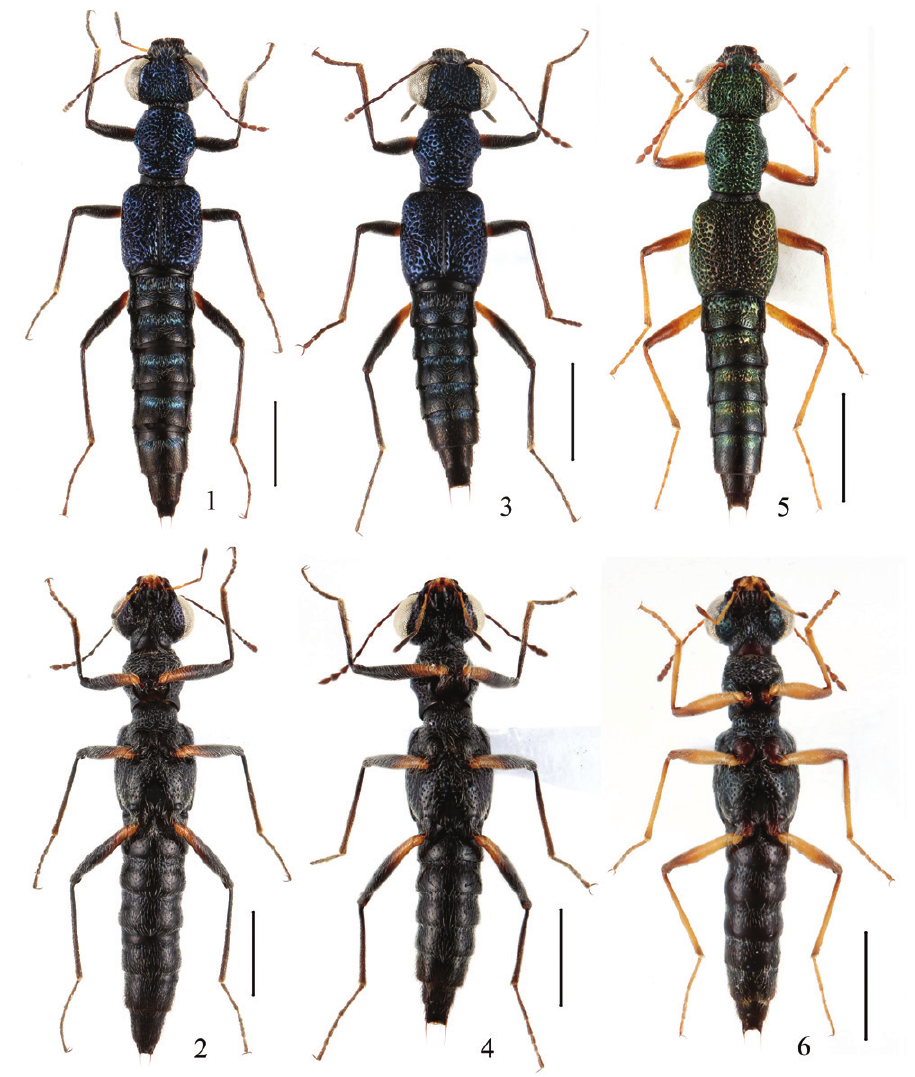
Figures 1–6. Adult habitus of Dianous. 1, 2 D. tonkinensis 3, 4 D. fengtingae 5, 6 D. shan . Scales = 1 mm. alt. 450–650m, 13.IV.2010, Zhu Jian-Qing leg. (female in cPut, female in cRou, rest in SHNU). Description. Body entirely black, head, pronotum, elytra and basal abdominal tergites with a blue metallic lustre. Antennae blackish brown, with club segments light- er. First two segments of maxillary palpi brownish yellow, last segment brown. Legs blackish with tibiae and tarsi slightly lighter, femora yellowish in basal third. BL: 4.5–4.9mm; FL: 2.5–2.6 mm. Proportions of holotype: HW: 63.5, PW: 47, PL: 53, EW: 61, EL: